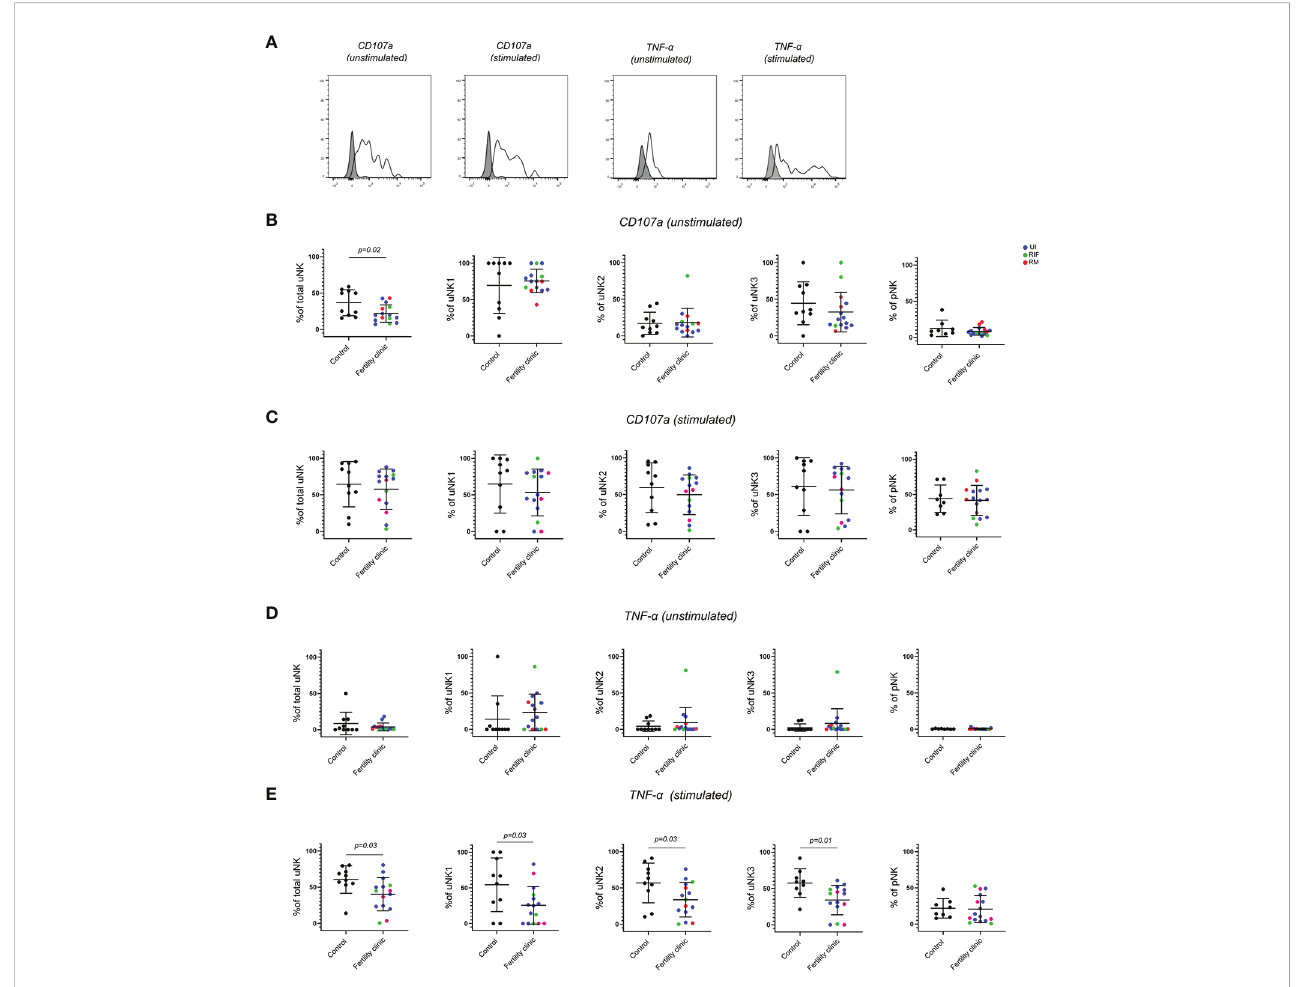
FIGURE 3 uNK are less active in women with reproductive failure. (A) Uterine and peripheral NK cells taken from control and UI, RM and RIF groups were cultured with or without PMA and ionomycin stimulation. Representative staining of one sample from total uNK is shown in clear alongside fl uorescence minus one control in grey. Graphs showing frequencies of CD107a (B, C) and TNF- a (D, E) on unstimulated and stimulated uNK and pNK. Means and standard deviations are shown for controls (n=11) shown in black and patients from fertility clinic including unexplained infertility (UI; n=9) showed in blue, recurrent miscarriage (RM; n=3) shown in red and recurrent implantation failure (RIF; n=3) shown in green. Statistical testing was done using unpaired t- test for normal or Mann-Whitney U test for non-normal distribution and p-values are shown on the graphs. Holm-Bonferroni correction for multiple hypothesis testing showed no signi fi cance for all the